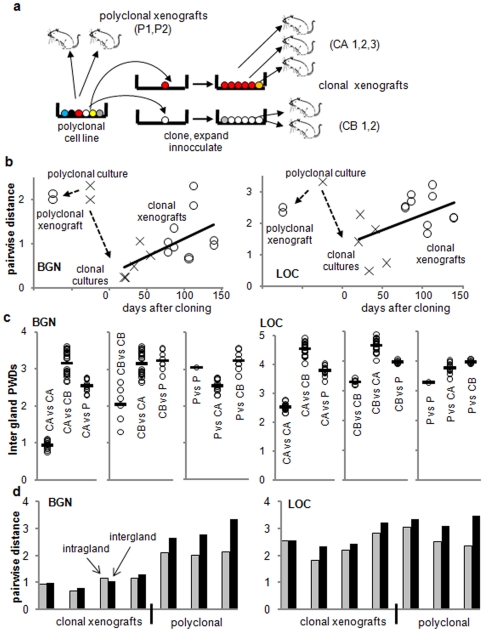
Experimental clonal evolution.
A. Schematic of the Lovo single cell cloning, first in culture and then as xenografts, simulating a clonal evolution bottleneck. B. Hitchhiking diversity decreases and then increases in culture and the xenografts after single cell cloning. (X's represent independent single cell clones in culture, and O's represent PWD averages among tags isolated from 5 to 6 small xenograft fragments) The LOC tag has a higher error rate compared to the BGN tag [12], and more quickly restores the diversity seen in polyclonal populations. C. Comparisons between fragments demonstrate intergland PWDs are smaller between clonally related tumors and larger between unrelated tumors, indicating the ability of the LOC or BGN tags to identify and distinguish between new and older clonal expansions (circles are averages of the fragment comparisons between the different xenografts, and bars are overall averages) D. Xenograft intragland PWDs are typically nearly as large as their intergland PWDs, indicating that the small tumor fragments are almost as diverse as their tumors.